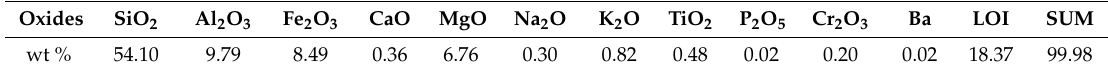
Table 1. Chemical composition of the Greek attapulgite clay that has been used as adsorbent in the present